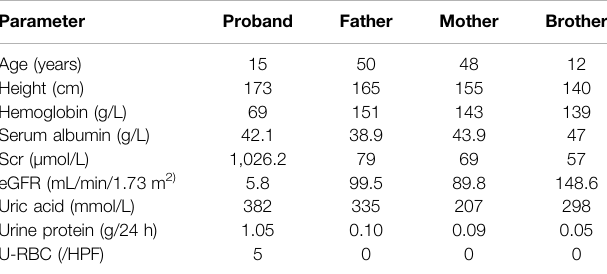
TABLE 1 | Clinical characteristics of the patient and his family.